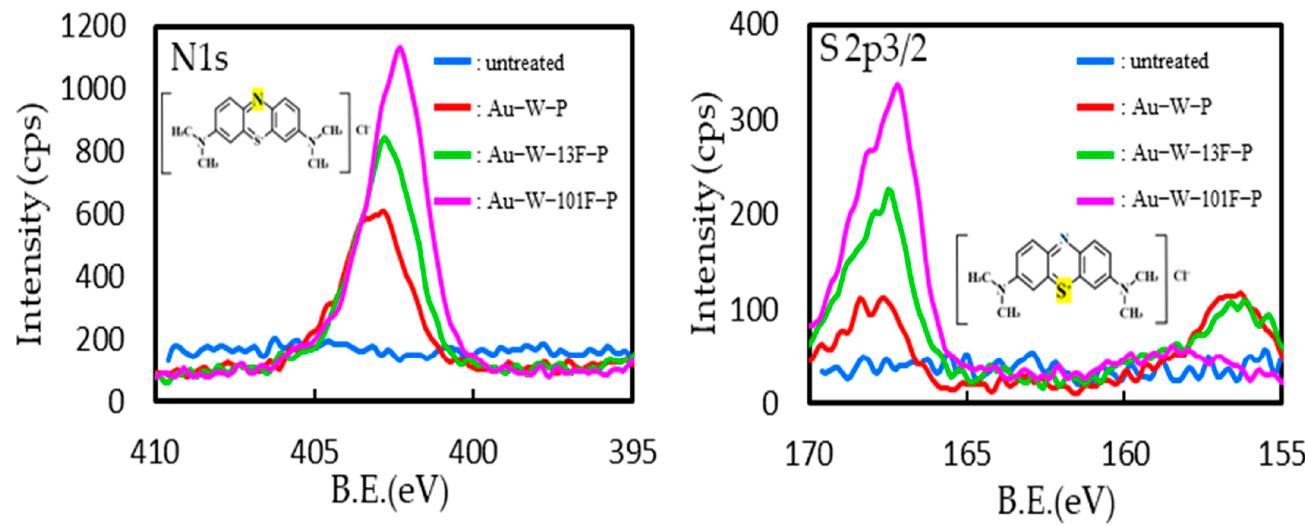
Figure 8. Photographs of dye staining of various PTFE samples with methylene blue.